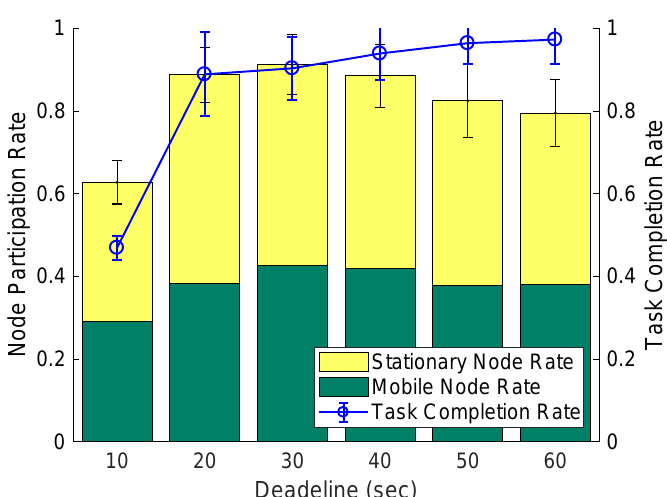
Figure 14. Task completion rate and node participation rate with respect to task deadline where the number of tasks is 120 in Topology 3.